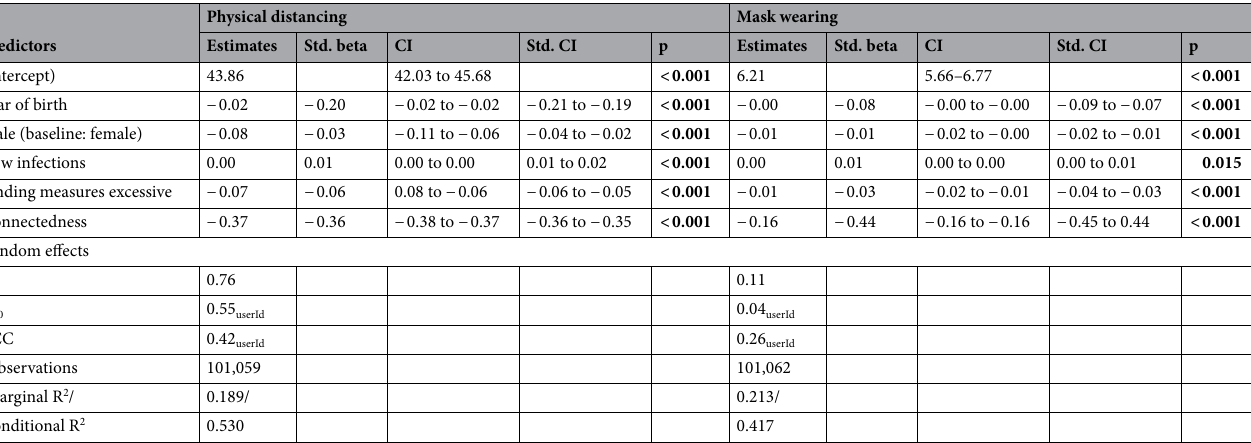
Table 5. Mixed model regressions from Study 3 predicting physical distancing and mask wearing. In Study 3, physical distancing and mask wearing behaviours in private contact situations were regressed on the slope of new infections, participants’ age and gender, their general attitude toward protective measures and their connectedness to the private contacts. Both analyses controlled for multiple participation (modelled as random